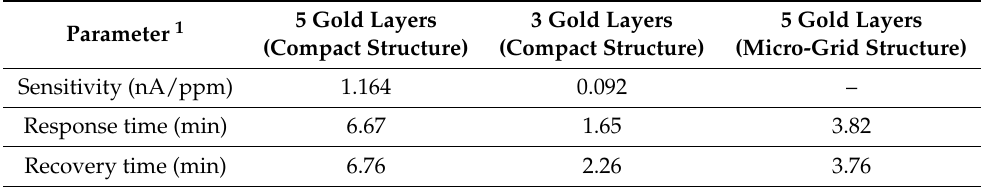
Table 2. Optimization of aerosol-jet printing (AJP) printed gold working